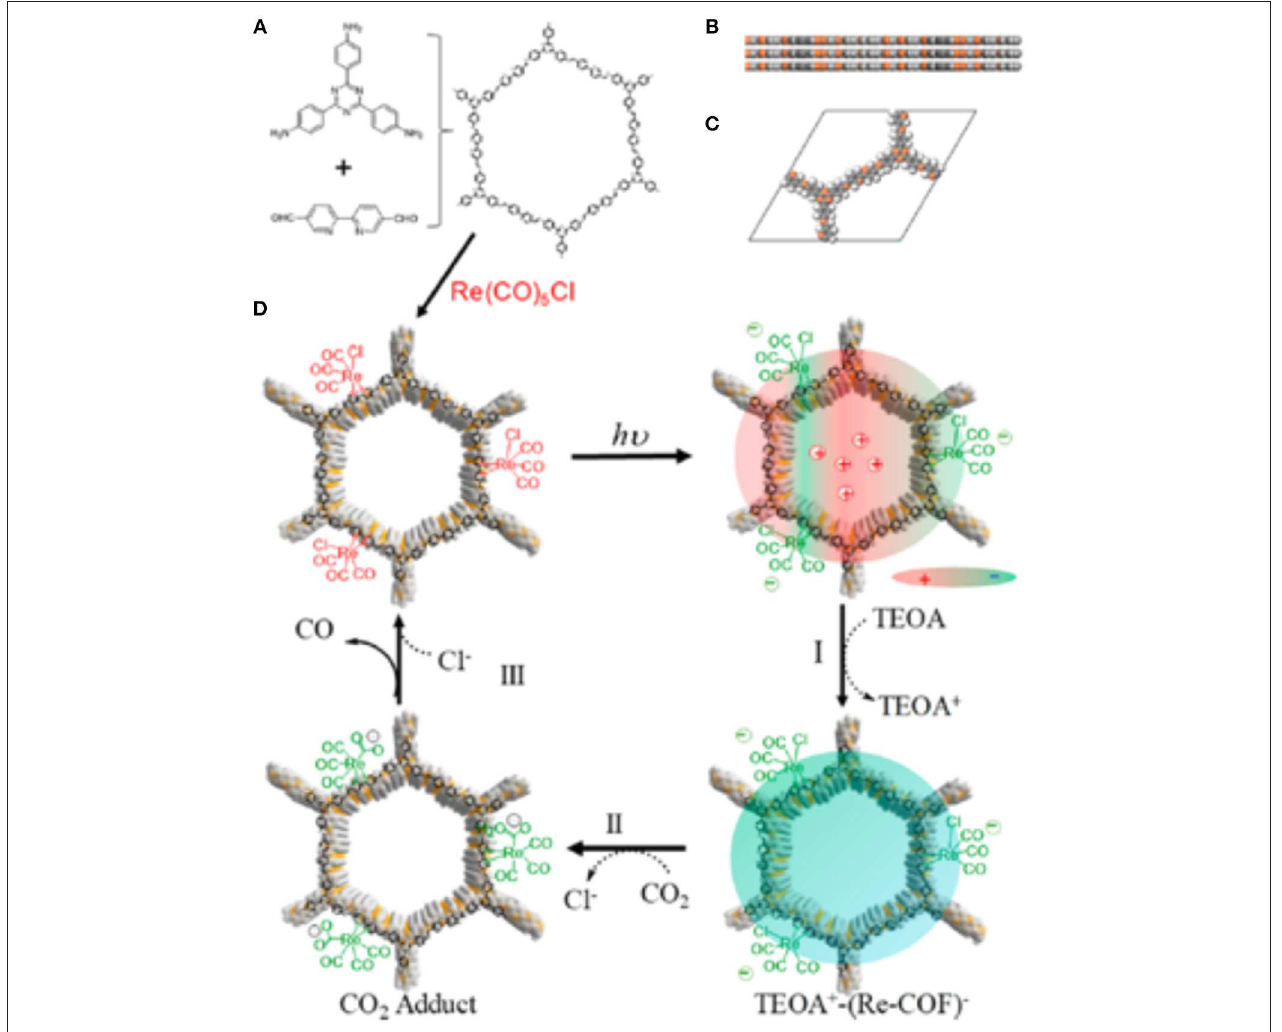
FIGURE 19 | (A) the building blocks and composition of Re-COF (B) View of stacked 2D sheets of Re-COF and (C) the unit cell of Re-COF. (D) Proposed mechanism of CO 2 reduction to CO by Re-COF: (Step I) Illumination initiates the catalytic cycle and forms the TEOA + -(COF-Re) − CS state by reducing ICT state via TEOA. (Step II) After 3h the absorbance from 500 to 800 nm decreases while the absorption at < 430nm and an isosbestic point of 430nm are observed. (Step III) Consistent CO production and spectral evolution halts. Reprinted with Permission © 2018 The American Chemical